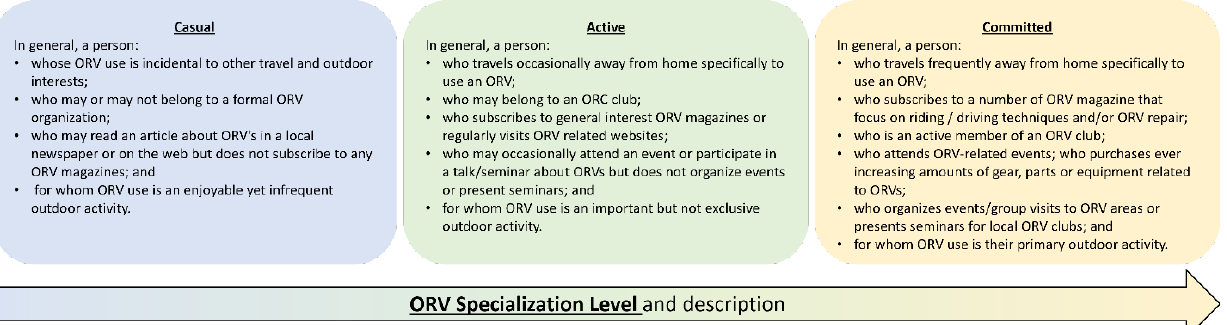
Figure 3. Recreation specialization levels of ORV users utilized, with descriptions presented to respondents for self-selection of single specialization level.